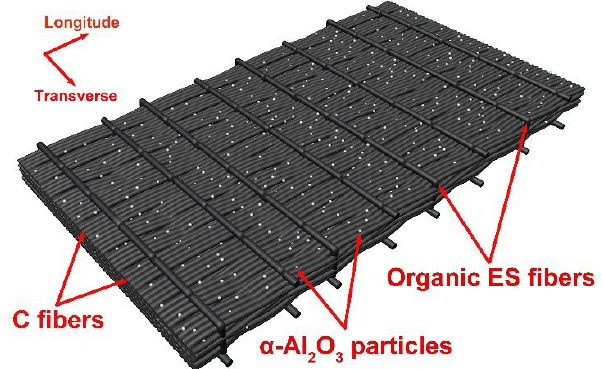
Figure 1. Schematic diagram of unidirectional, laminated T800 carbon fibers preforms.